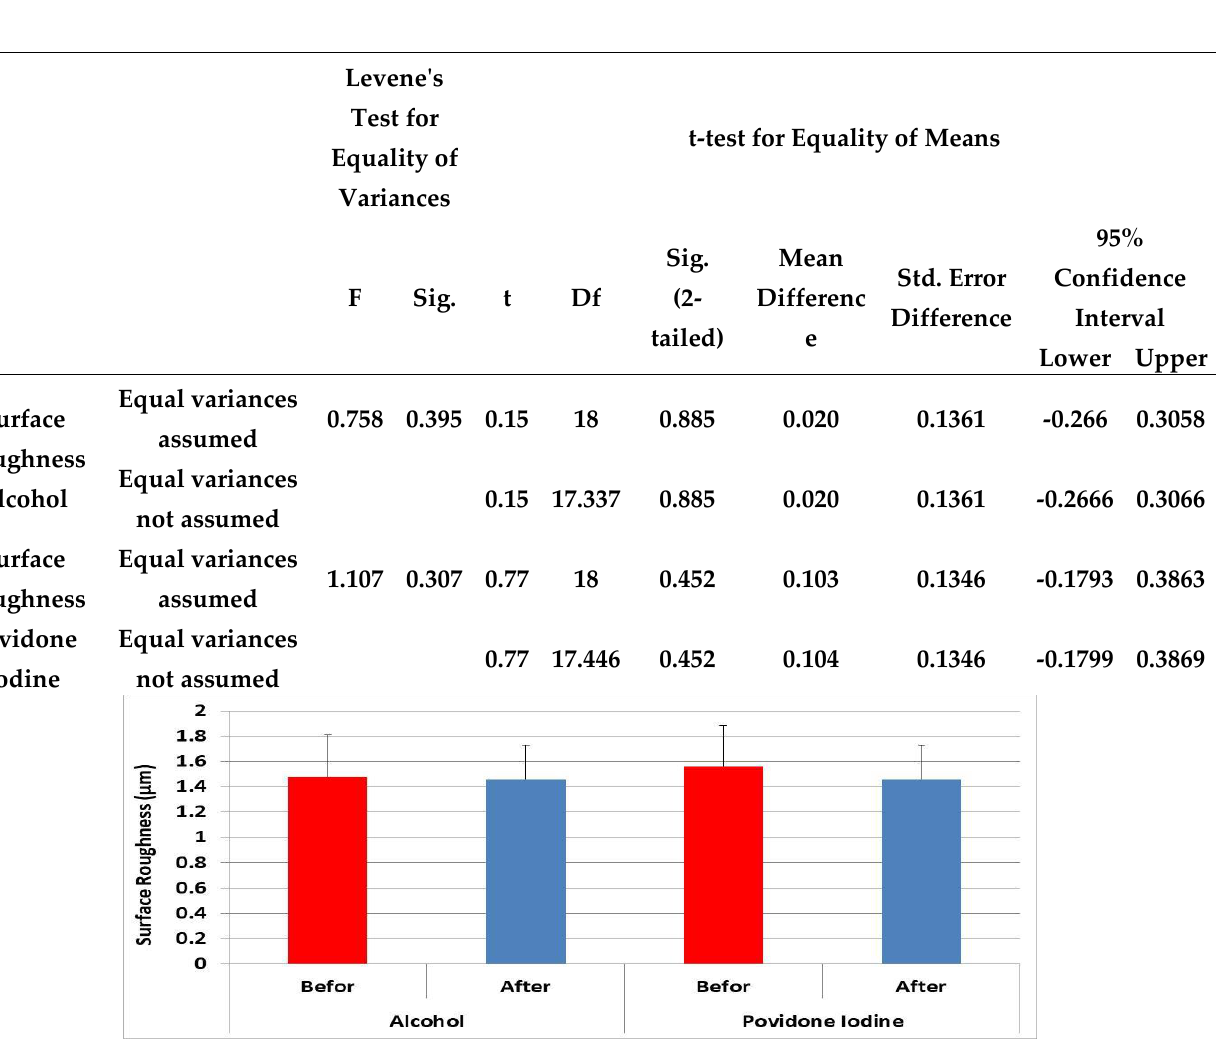
Table (4) : F- and T-test of experimental groups